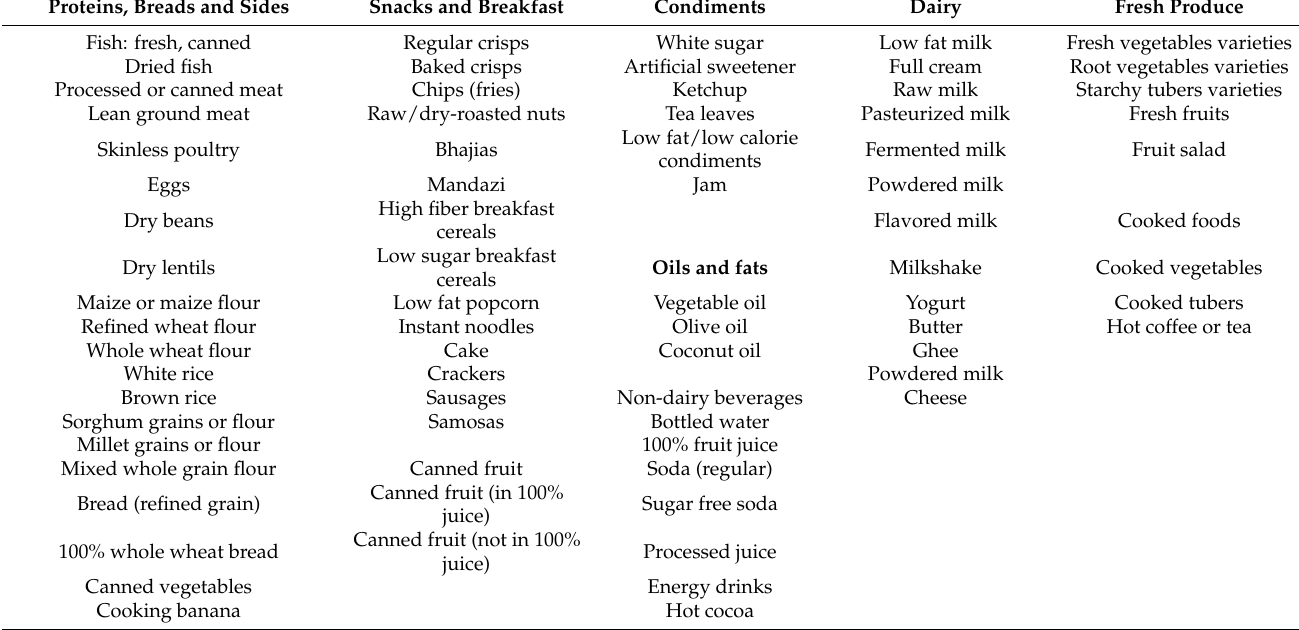
Table A2. Food retail outlets’